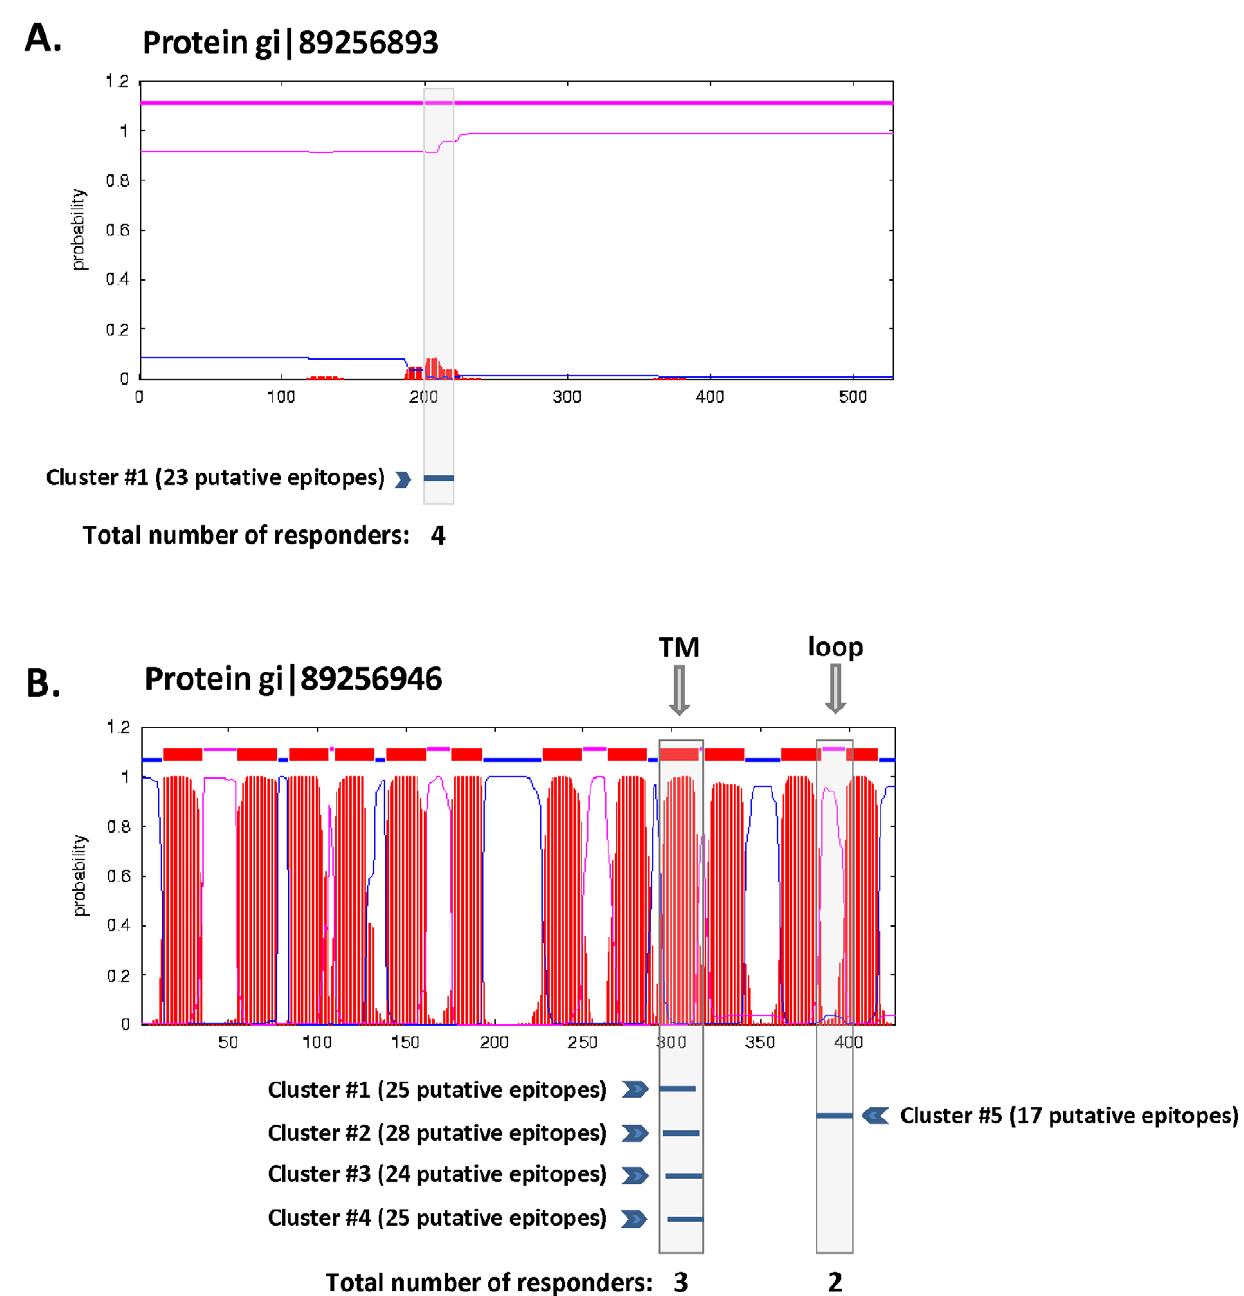
Figure 6. Distribution of clusters of CTL epitopes in a representative non-membranal and membrane-spanning protein and alignment with transmembrane a -helices and loops. Sample plots of the topological map (generated by TMHMM predictions) of two representative proteins. Red segments represent the probability of having a helical region, while the thin blue and pink lines represent inside and outside loops, respectively. In the lower part of every protein chart, a bar represents a cluster of predicted epitopes. Co-localization of the putative MHC binders with the predicted helix or loop region in the protein is marked by a grey box. (A) A sample of a non-membranal protein (gi|89256893) carrying a cluster at density 0.8, harboring 23 putative epitopes, four of which are a responders. This represents the 18% non-membranal proteins carrying high density clusters (see Figure 4). (B) A sample of a transmembrane protein (gi|89256946) carrying four clusters (clusters # 1–4) within a a - helical transmembrane domain, (marked by ‘‘TM’’), and an additional cluster (cluster # 5) co-localized with an outside loop domain (marked by ‘‘loop’’) between two transmembranal regions. The total number of putative epitopes in clusters # 1–4 is 102 and in cluster # 5 is 17, which contain 3 and 2 responders, respectively. This sample protein provides an example for the high frequency of clusters in helical regions but also demonstrates the presence of high density clusters in loops (there are examples of other proteins, not shown, where clusters span both transmembrane and loop regions).